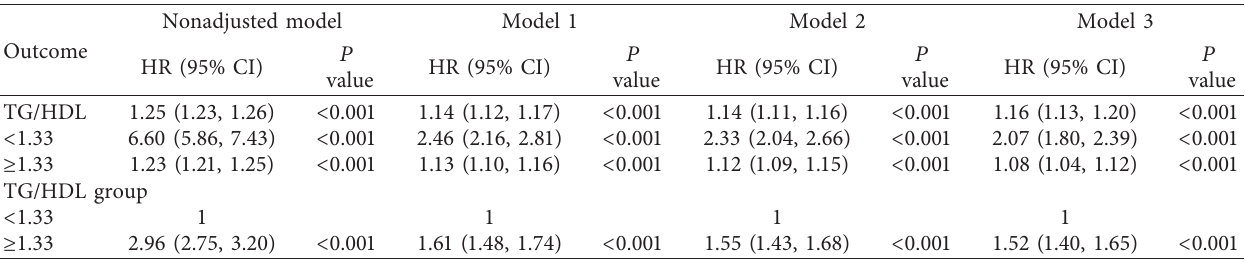
Table 6: The association between TG/HDL and diabetes in a multiple regression